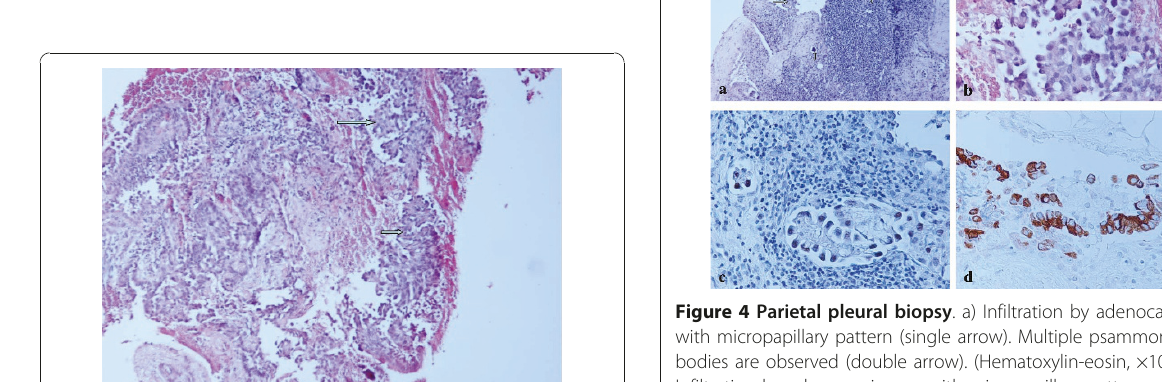
Figure 4 Parietal pleural biopsy . a) Infiltration by adenocarcinoma with micropapillary pattern (single arrow). Multiple psammoma bodies are observed (double arrow). (Hematoxylin-eosin, ×100). b) Infiltration by adenocarcinoma with micropapillary pattern. (Hematoxylin-eosin, ×400). c) Immunohistochemical nuclear TTF-1 positivity of malignant cells. (×400). d) Immunohistochemical cytoplasmic SP-A positivity of malignant cells.